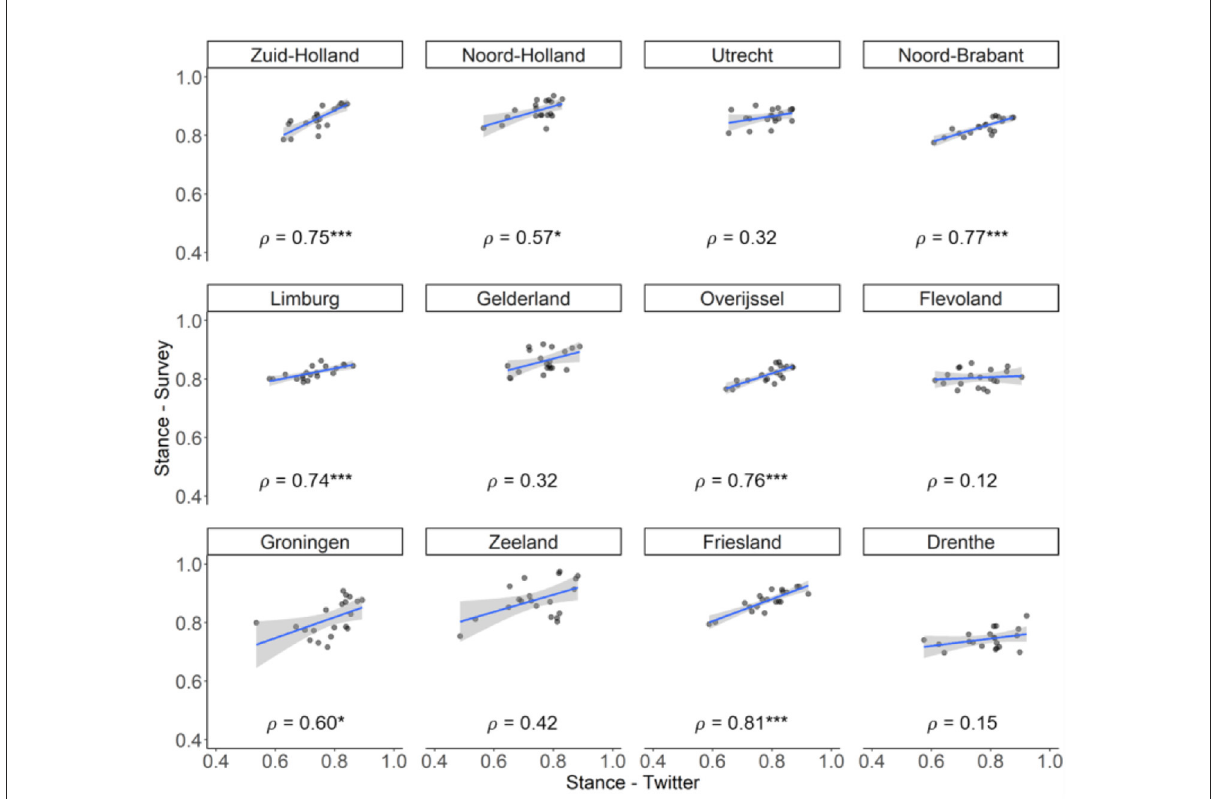
FIGURE4 Scatterplots showing the correlations between stance estimated from Twitter and survey data for the Dutch provinces. Provinces are ordered from left to right and top to bottom based on their population density. The x- and y-axes are restricted to [0.4, 1] in order to show the temporal changes more clearly. Significance indicator: P < 0.05 * , P < 0.001 ***